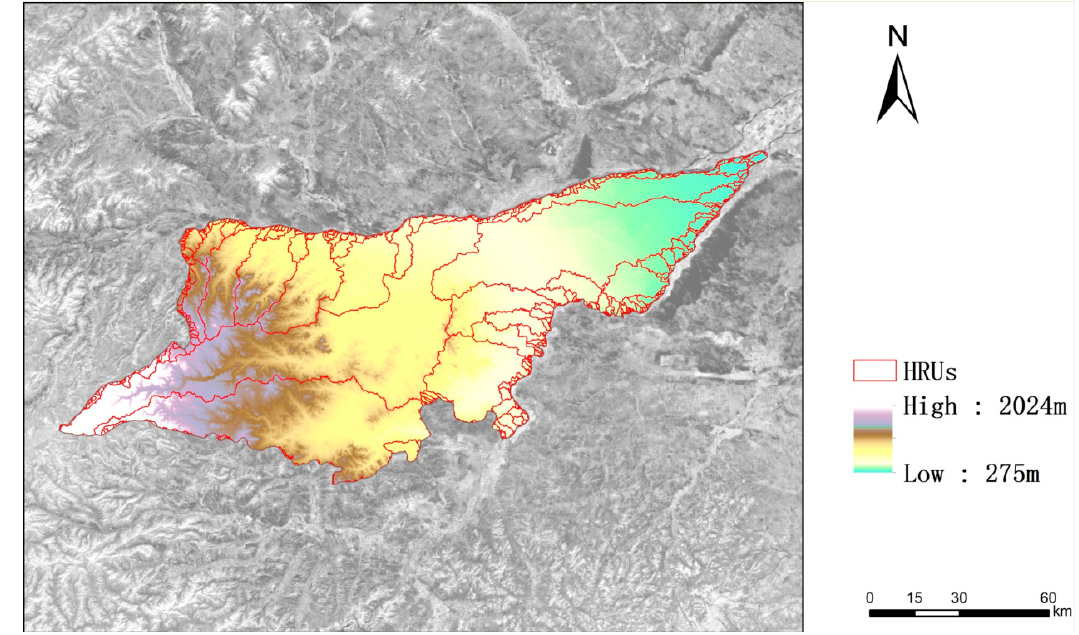
Figure 7. Hydrological response unit distribution map.